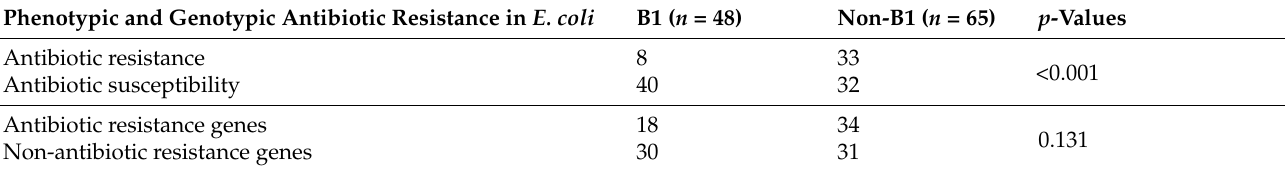
Table 5. Associations between the antibiotic susceptibility and antibiotic resistance genes of E. coli and Phylogenetic Group (B1 and Non-B1).